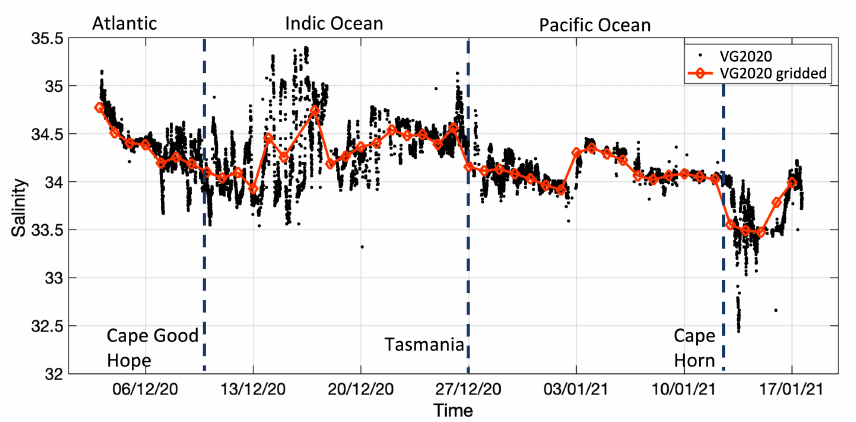
Figure 10. Original high-frequency VG2020 salinity measurements (black dots) and the collocated